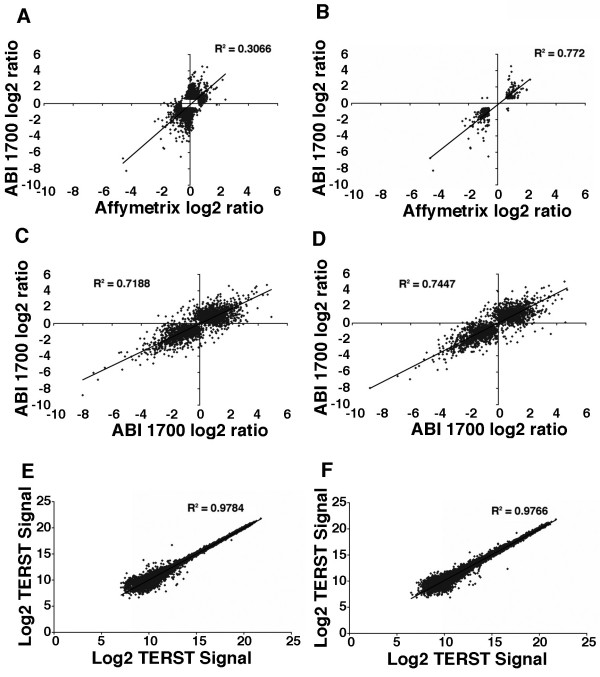
(A) Scatterplot comparison of the log2 ratio of gene expression data between HEK-TERST and HEK-TERV cells. Log2 ratios from the AB platform are plotted on the y-axis and from the Affymetrix platform on the x-axis. The genes plotted include any gene identified as significantly changed on either platform. (B) Scatterplot comparison similar to panel (A), except that only the 278 genes significantly altered on both platforms are shown. (C) Scatterplot of the log2 ratio of HEK-TERST and HEK-TERV cells comparing different technical replicates on the AB platform. (D) Scatterplot comparison as in panel (C), except comparing biological replicates on the AB platform. (E) Scatterplot comparison of the log2 transformed absolute signal from HEK-TERST cells from two technical replicates on the AB platform. (F) Scatterplot comparison of the log2 transformed absolute signal from HEK-TERST cells from two biological replicates on the AB platform.